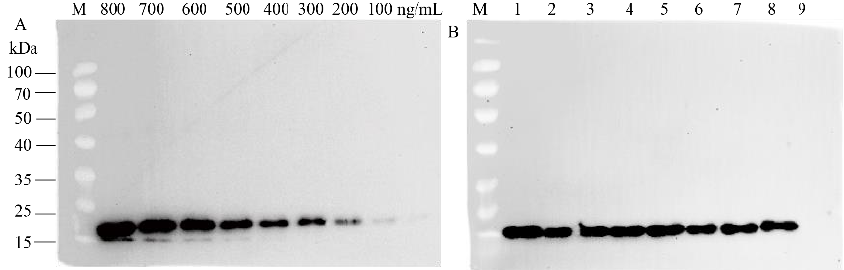
Figure 7. Western blot detection of recombinant protein from transgenic duckweed plants. ( A ) Western blot analysis of various concentrations of standard 17B purified from E. coli . ( B ) Western blot analysis of protein samples from plants. M: protein mark, 1–7: transgenic lines, 8: the standard protein (400 ng/mL), 9: wild plant.